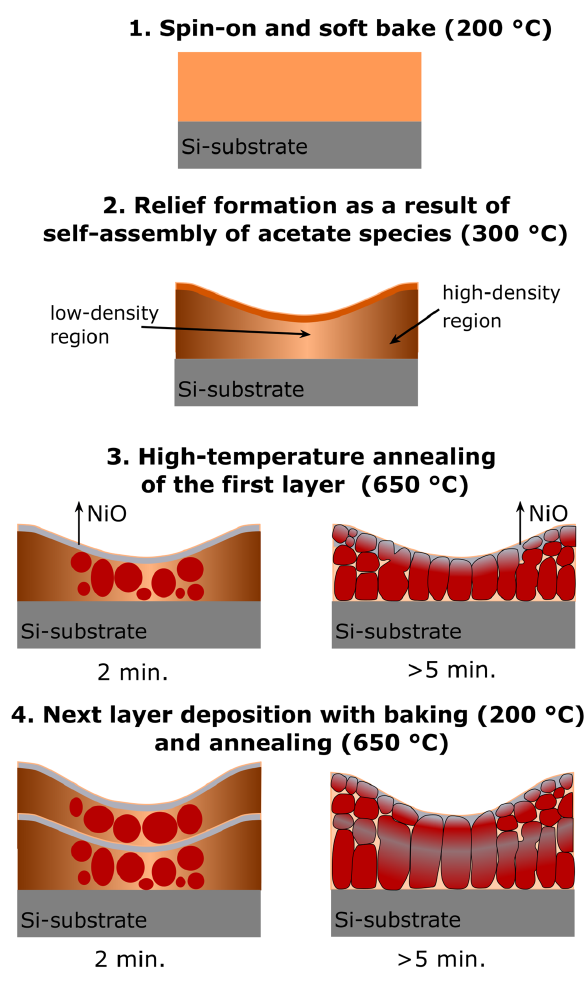
Figure 16. Model of LNO film crystallization.